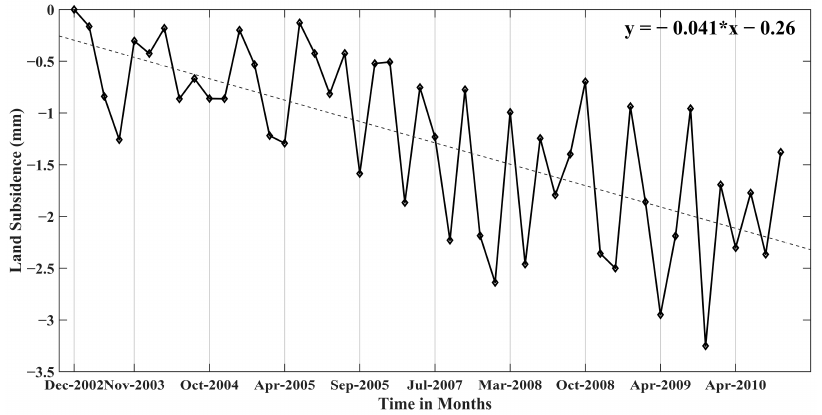
Figure 4. Time series of average subsidence for central